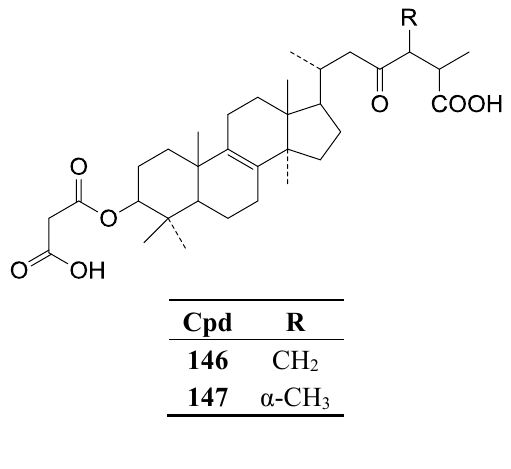
Figure 17. Structures of compounds 146 ‒ 147